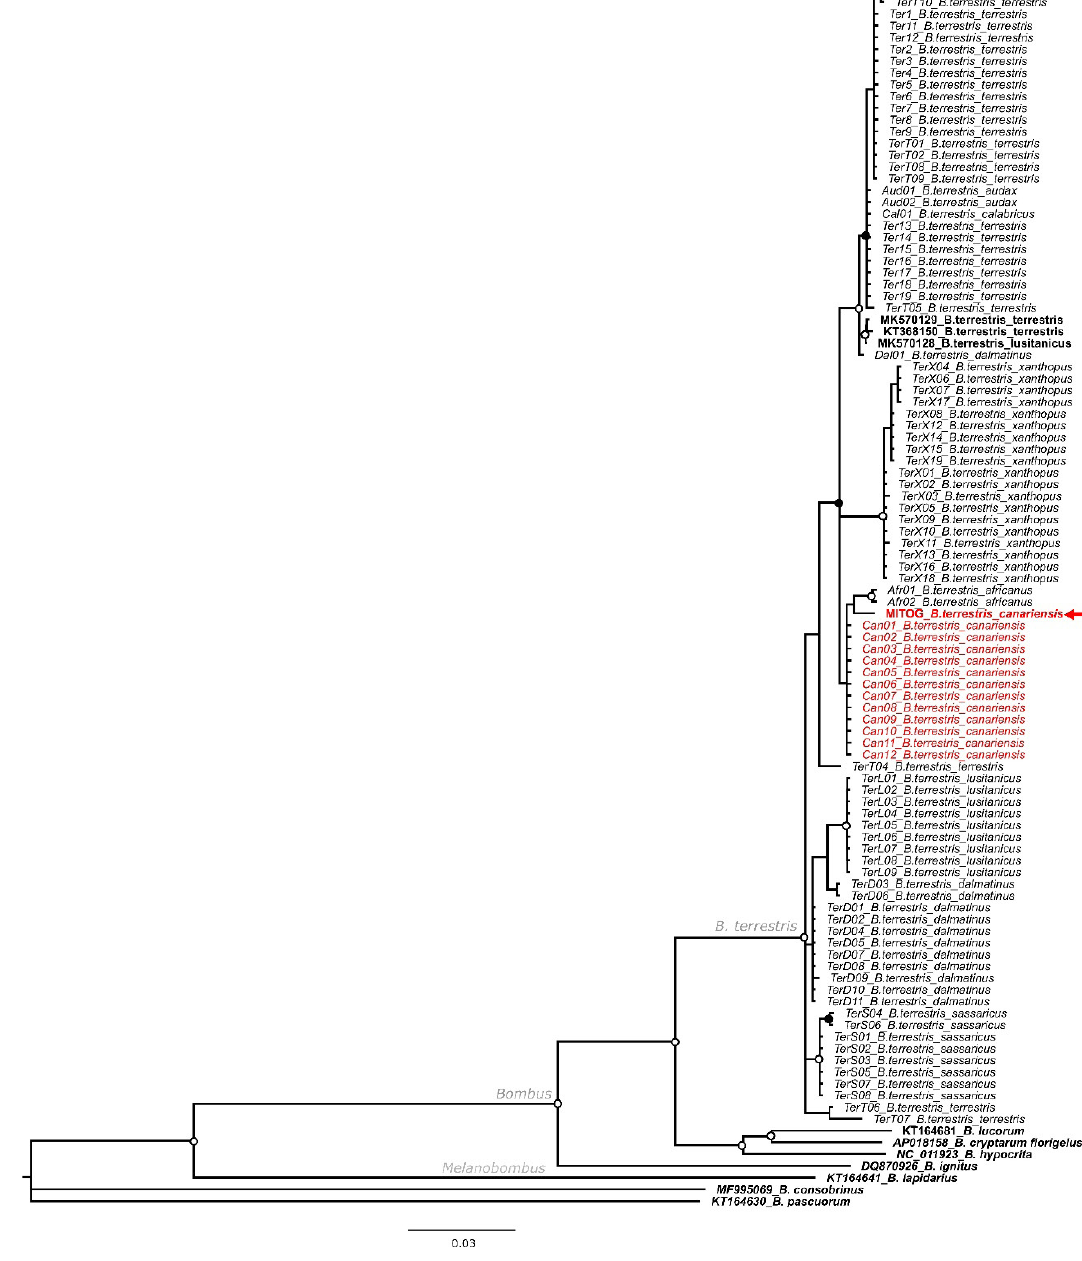
Fig 2 . Bayesian phylogenetic tree showing the relationship between Bombus terrestris canariensis (in red) and other eight B. terrestris subspecies. An arrow indicates the B. t. canariensis mitogenome sequenced in this study and bold names the mitogenomes used. Empty and filled circles indicates posterior probabilities of 0.90-0.95 and >0.95